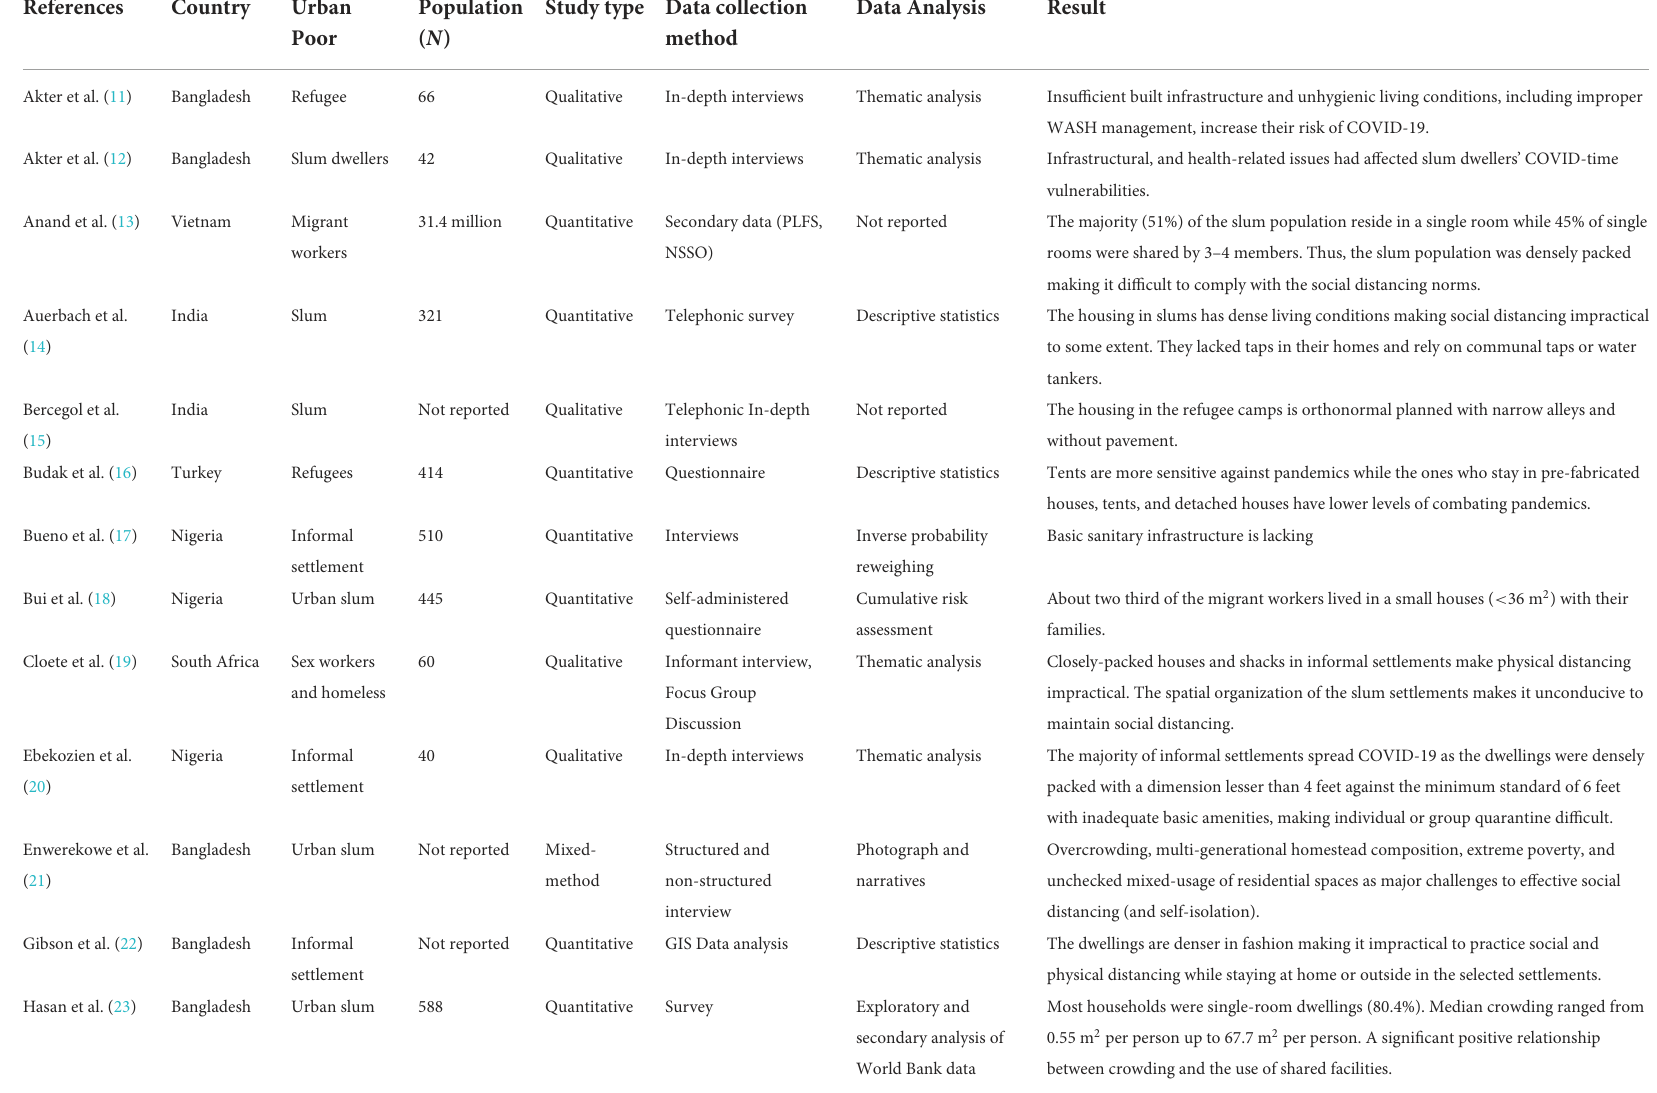
TABLE 1 Characteristics of included